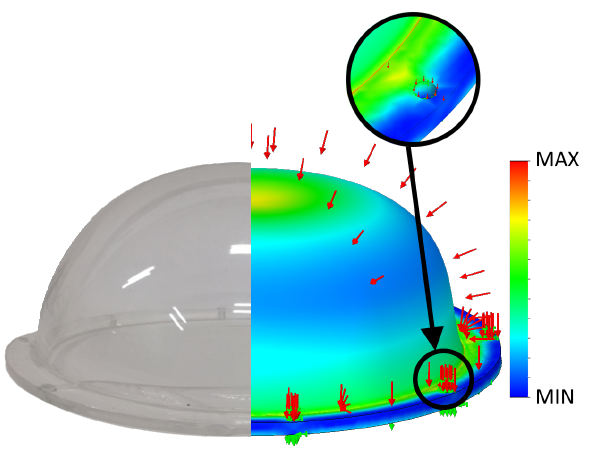
Figure 18. Compression rupture.